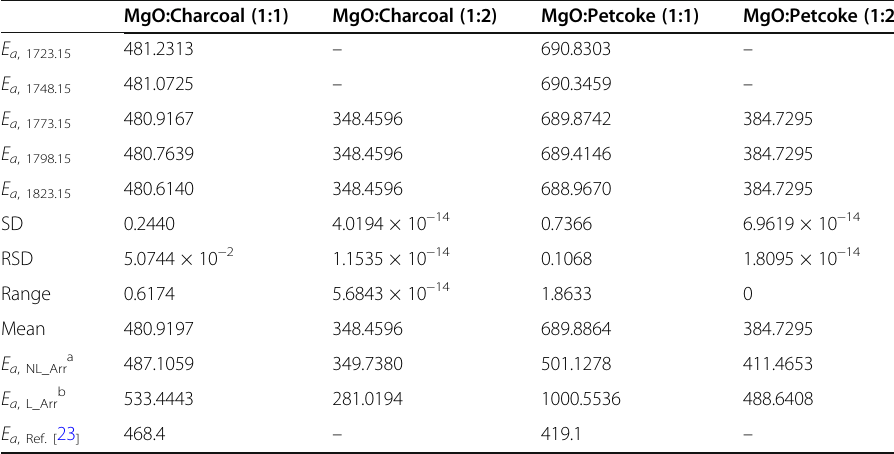
Table 5 The comparison of values of E a /(kJ mol − 1 ) obtained from different methods as well as the relevant statistical quantities for reactions of MgO with carbonic reductants in different molar ratios and at temperatures 1723.15 K, 1748.15 K, 1773.15 K, 1798.15 K, and 1823.15